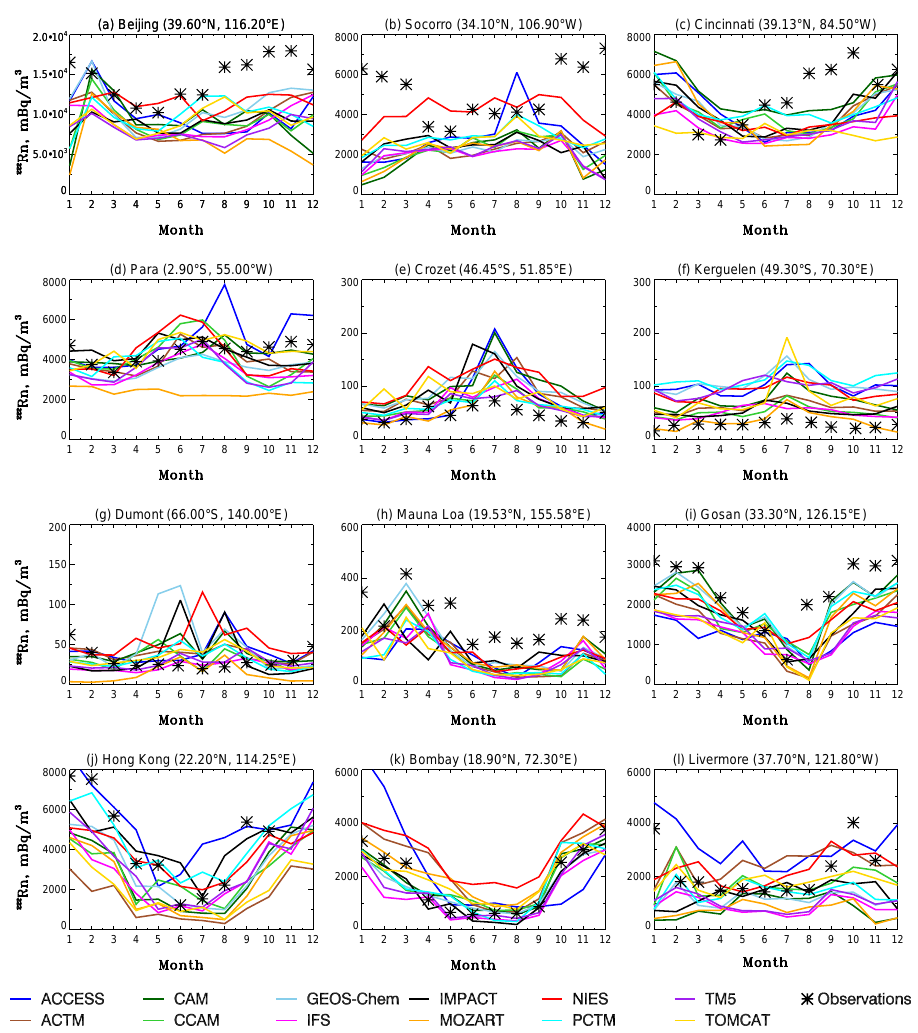
Fig. 10. Observed and simulated monthly mean surface radon concentration at continental (a–d) , remote island (e–h) and coastal (i–l) sites. Note different scales for